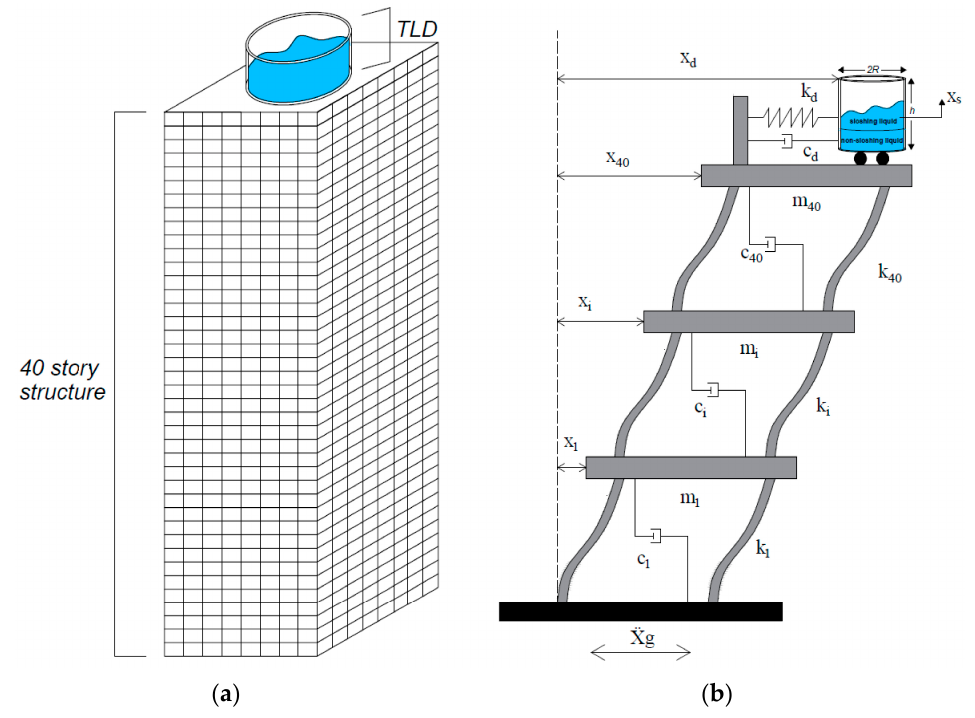
Figure 15. TLD + 40 ‐ story structure models: ( a ) 3D and ( b ) idealized model. Figure 15. TLD + 40-story structure models: ( a ) 3D and ( b ) idealized model. The obtained TLD design parameters of the forty-story structure model with the The obtained TLD design parameters of the forty ‐ story structure model with the op ‐ optimization process are shown in Table 9. timization process are shown in Table 9. Table 9. Optimum results for all TLD liquids in the 40 ‐ story structure. Table 9. Optimum results for all TLD liquids in the 40-story